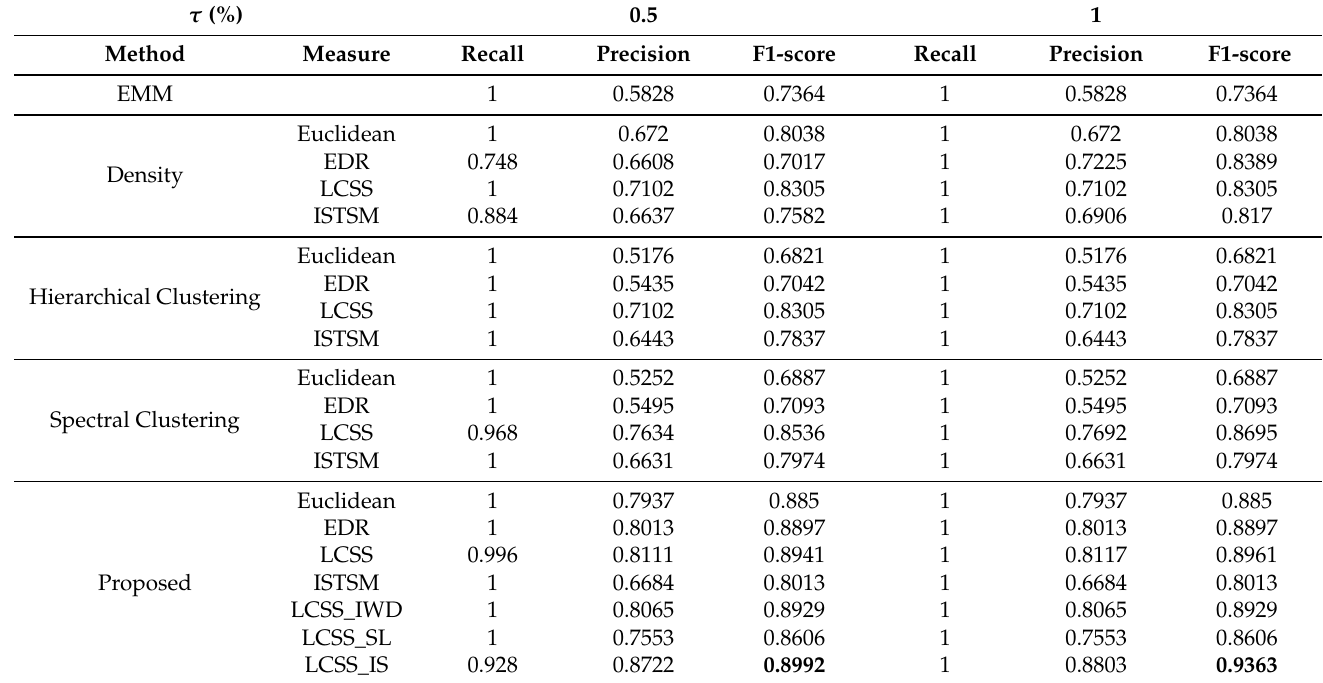
Table 4. Results with rare location visiting anomaly on the sCREEN